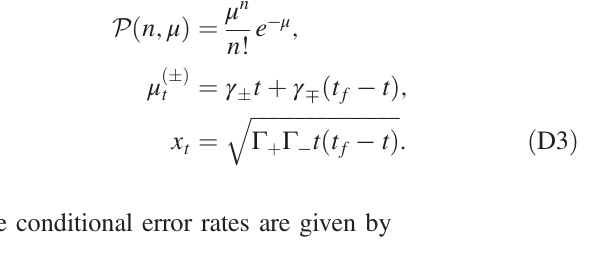
FIG. 9. Evolution of the NV − probability p generated assuming jþi (solid blue) and j − i (dashed red) for the same parameters as in Fig. 5. In this particular case, we assumed that P ðþÞ ¼ P ð − Þ . The discontinuities in p detection of a photon. Data acquisition is stopped when p crosses the stopping thresholds p t reaches the maximum acquisition time t